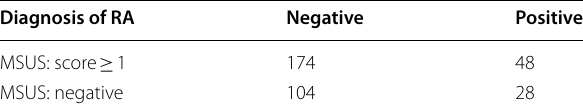
MSUS results and RA diagnosis of 354 out of 560 participants, which underwent the MSUS investigation and visited a rheumatologist for further assessment